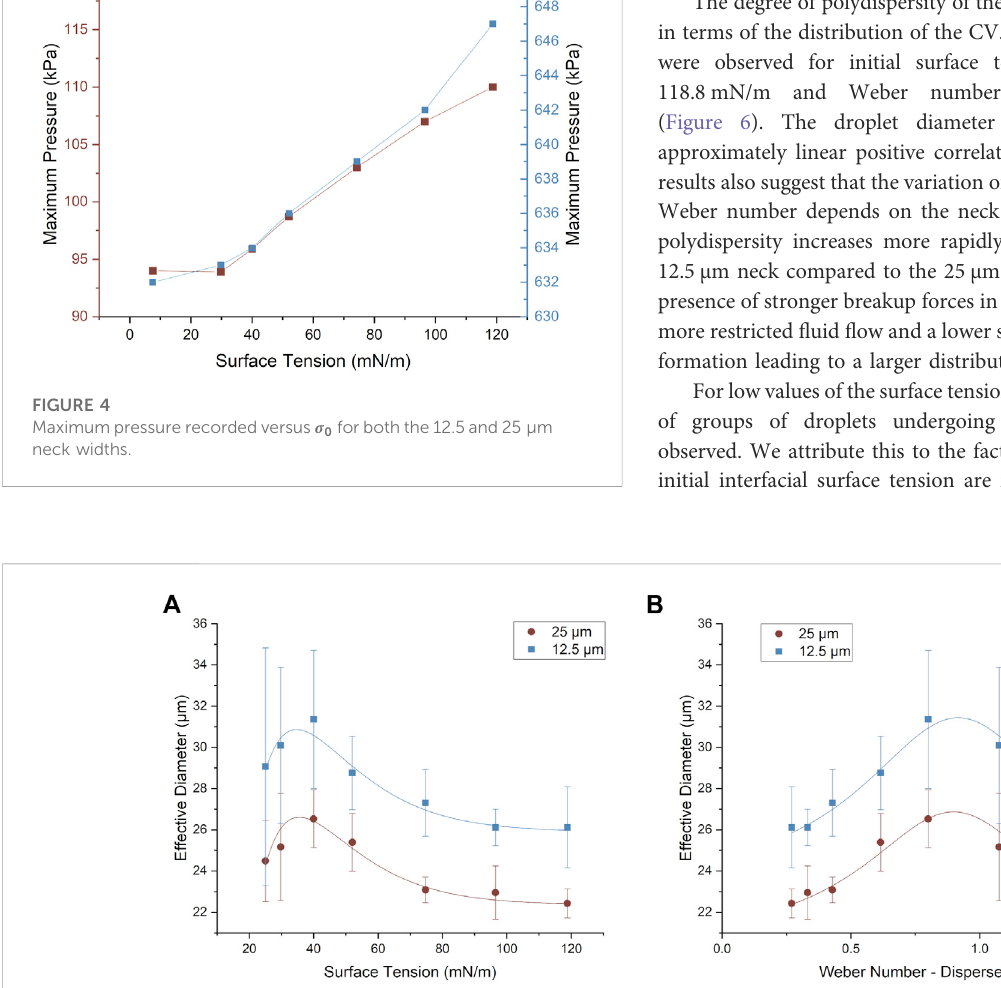
FIGURE 5 Effective droplet diameter as a function of (A) σ 0 and (B) Weber number of the dispersed phase (We d ) for the 12.5 and 25 µm neck widths. The effective diameterwascalculatedbasedontheassumptionofaperfectlysphericaldropletwhosevolumewassettobeequivalenttotheactualaveragedropletvolume measured from the simulations. The error bars are the standard deviation.